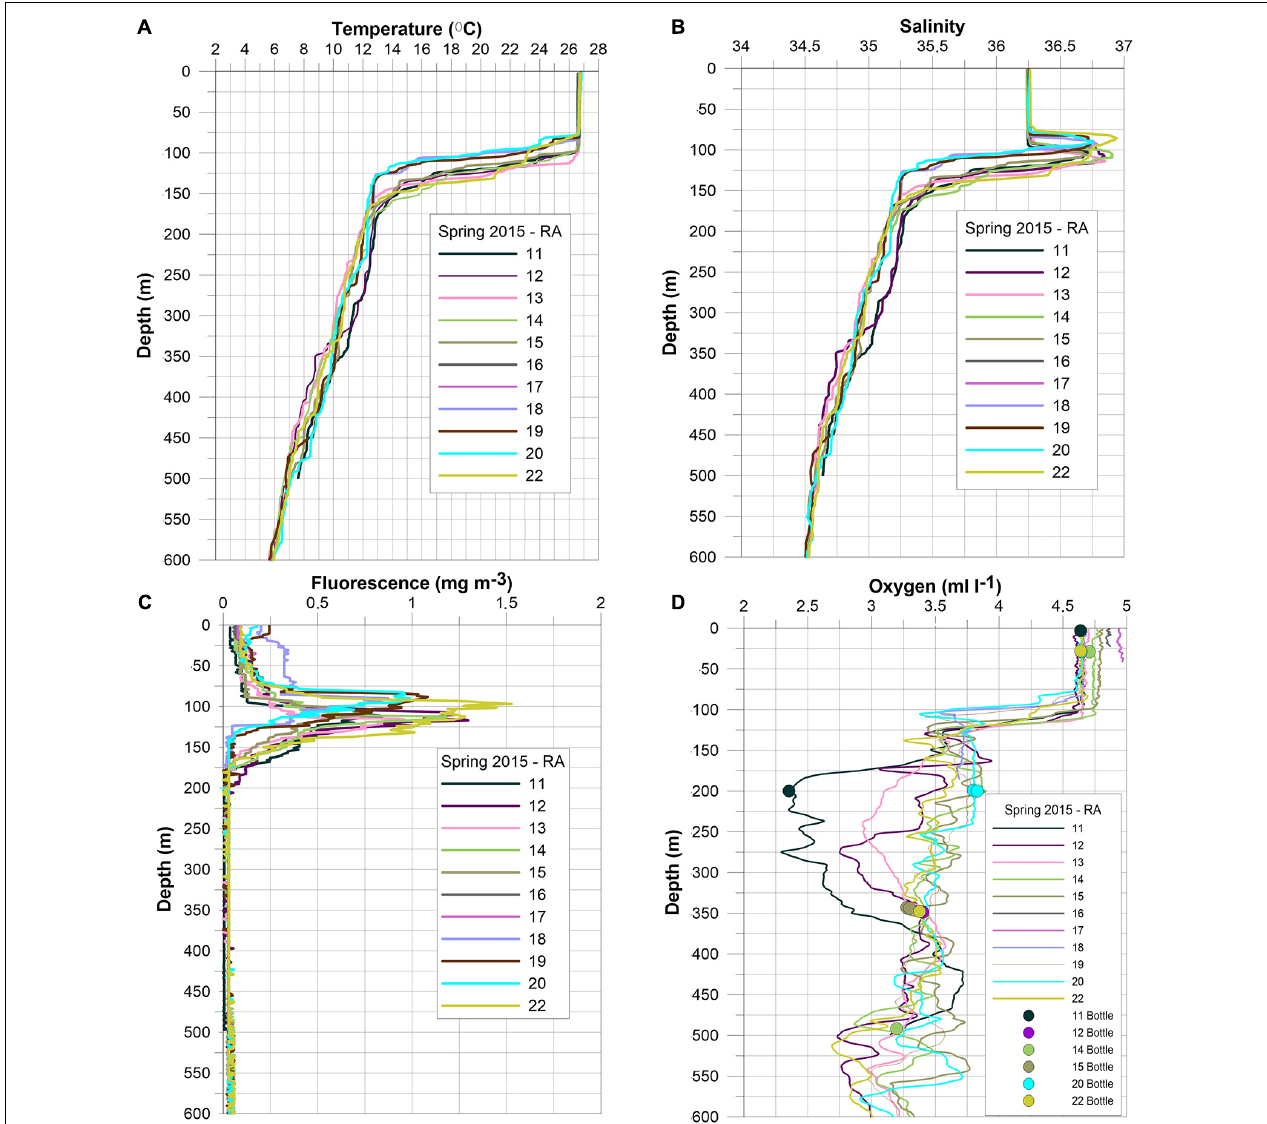
FIGURE 5 | CTD profiles obtained during the ABRACOS surveys in spring 2015 around the Rocas Atoll. Vertical profiles of temperature (A) , salinity (B) , fluorescence (C) , and dissolved oxygen (D)